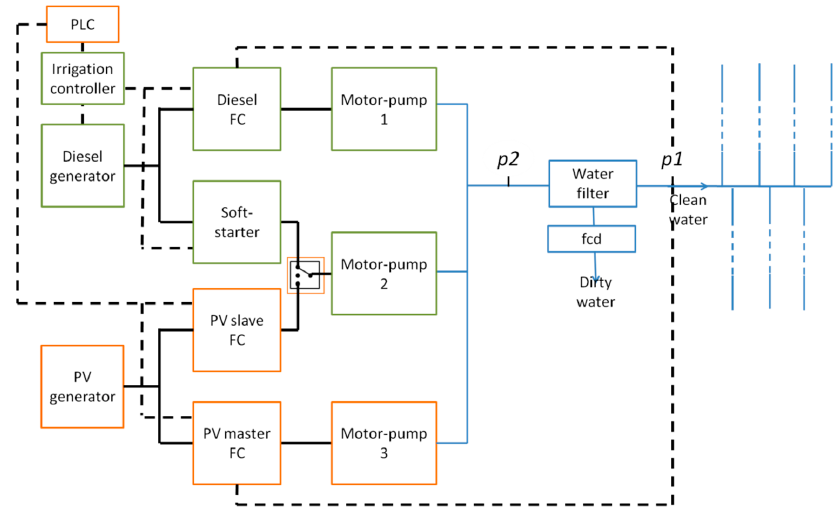
Figure 3. Hybrid irrigation system configuration. A PV generator, a new motor-pump, and two FCs have been added to the pre-existing configuration of Figure 1. The new components are marked in orange, while the previous ones are in green.